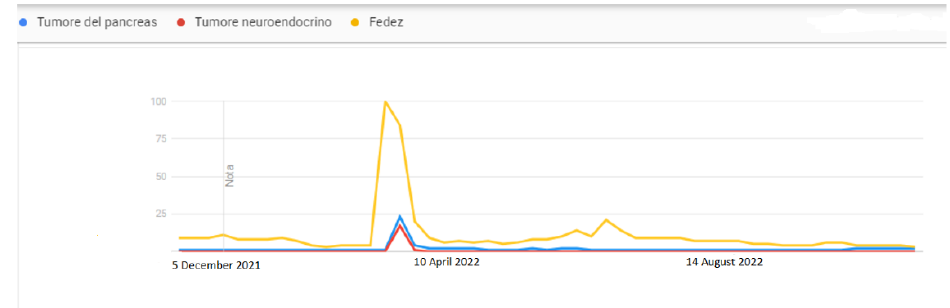
neuroendocrino in Italian. Period analyzed from 3 October 2021 to 30 October 2022; data were ag- gregated weekly.